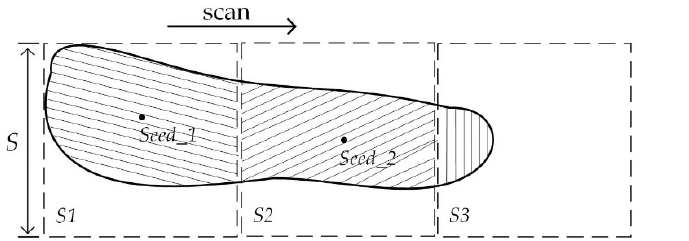
Figure 7. Example of the seed sampling strategy for an initial homogeneous region that cannot be completely covered by S .